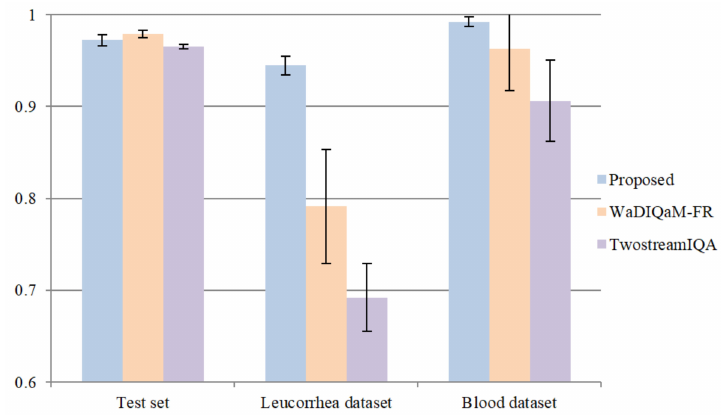
Figure 11. Comparison with two deep-learning-based NR-IQA methods.